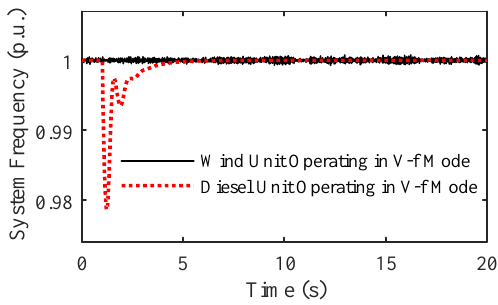
Figure 10. Frequency of the stand-alone system for two different operational approaches. Table 1. ROCOF and ROCOV of the system.